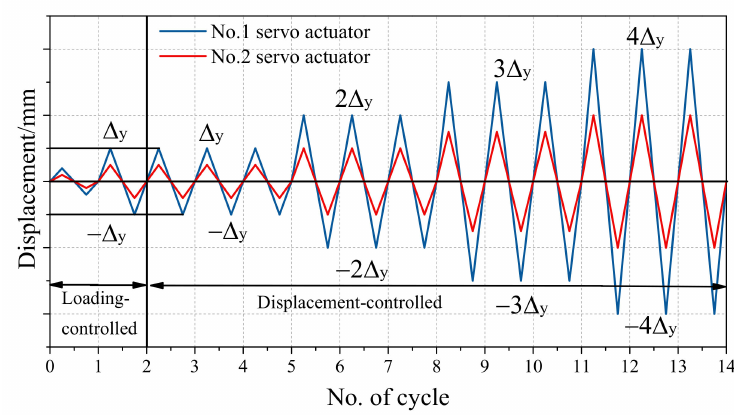
Figure 4. Loading history.